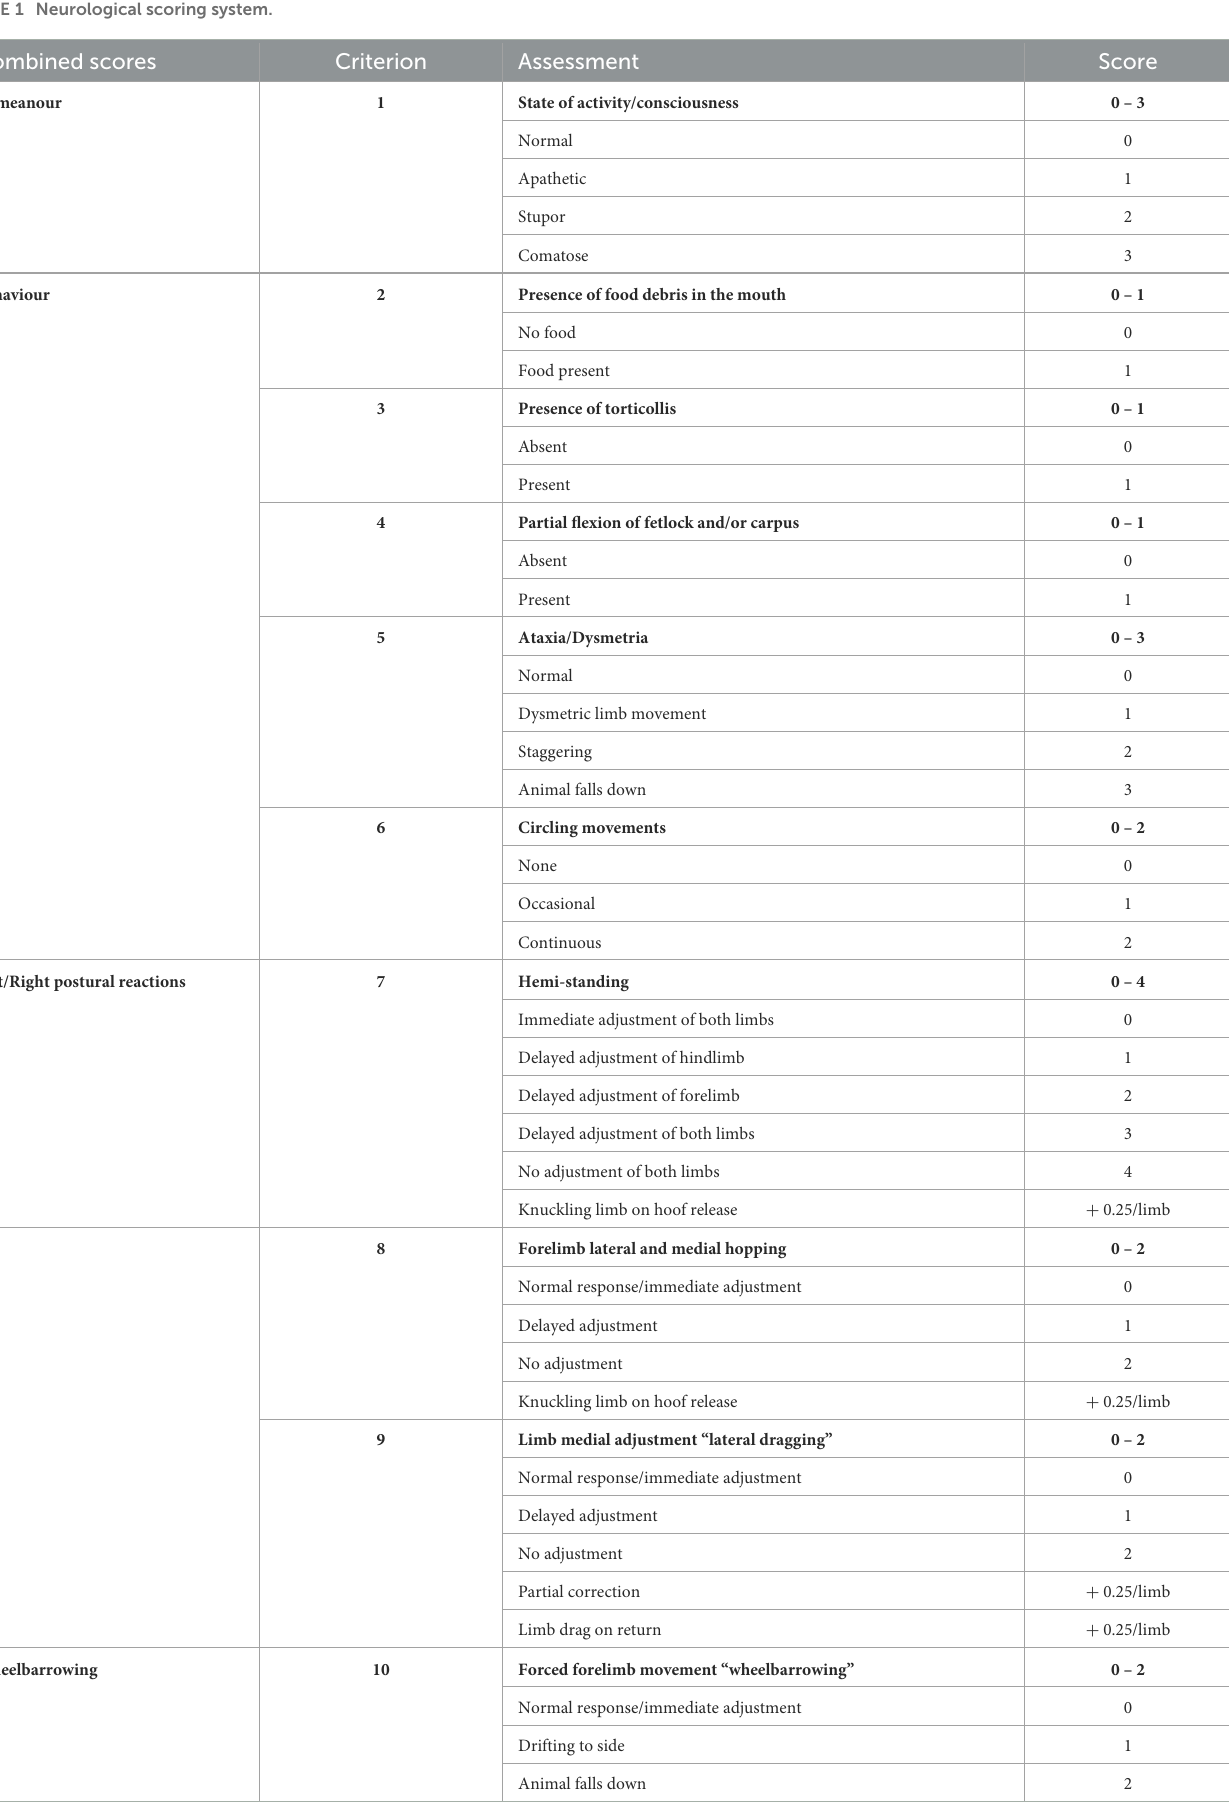
TABLE 1 Neurological scoring